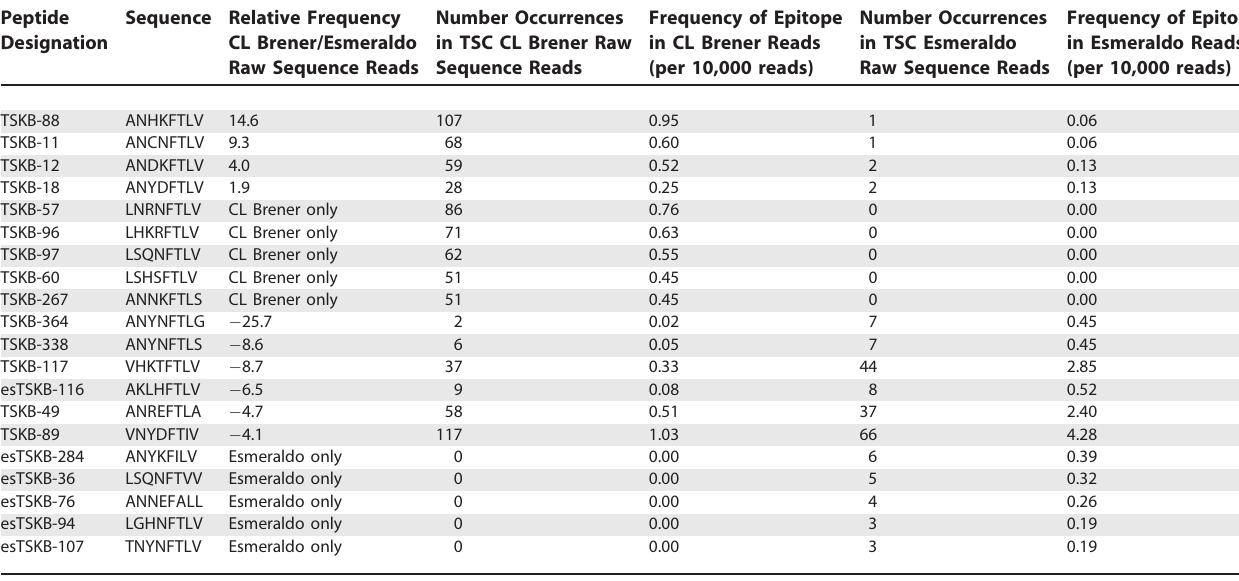
Table 1. Differential Distribution of ts Genes among Closely Related T. cruzi Strains Peptide Sequence Relative Frequency Designation CL